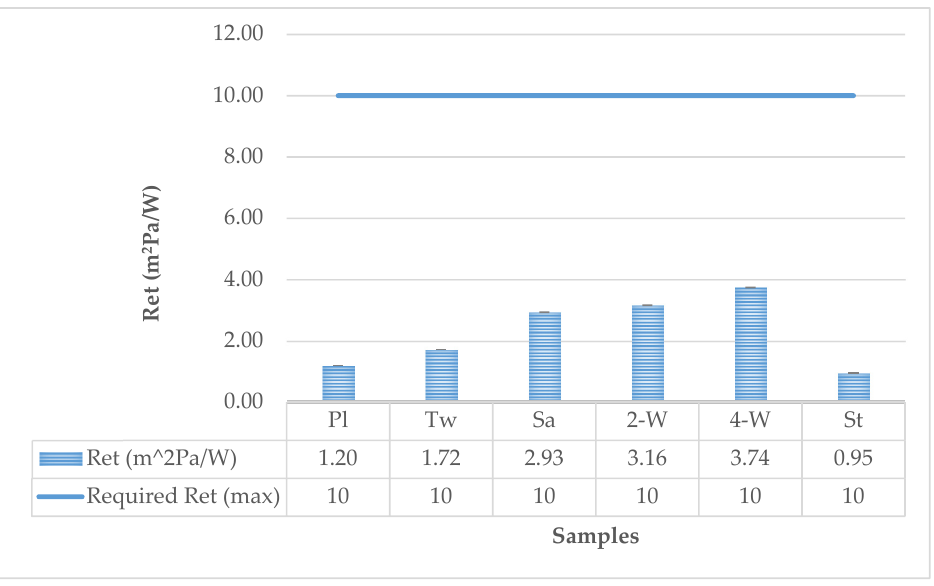
Figure 7. Vapor resistance compared to requirements according to the standard EN 15614 Protective clothing for firefighters requirements for wildland clothing test methods and requirements.